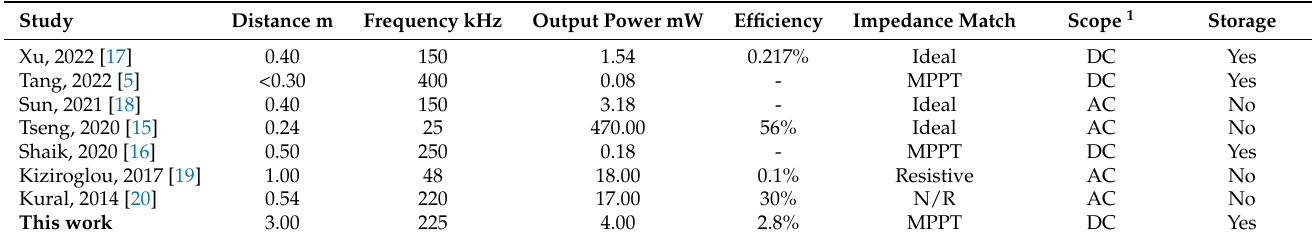
Table 1. Summary of existing studies on lamb-wave-based WPT through metal channels.